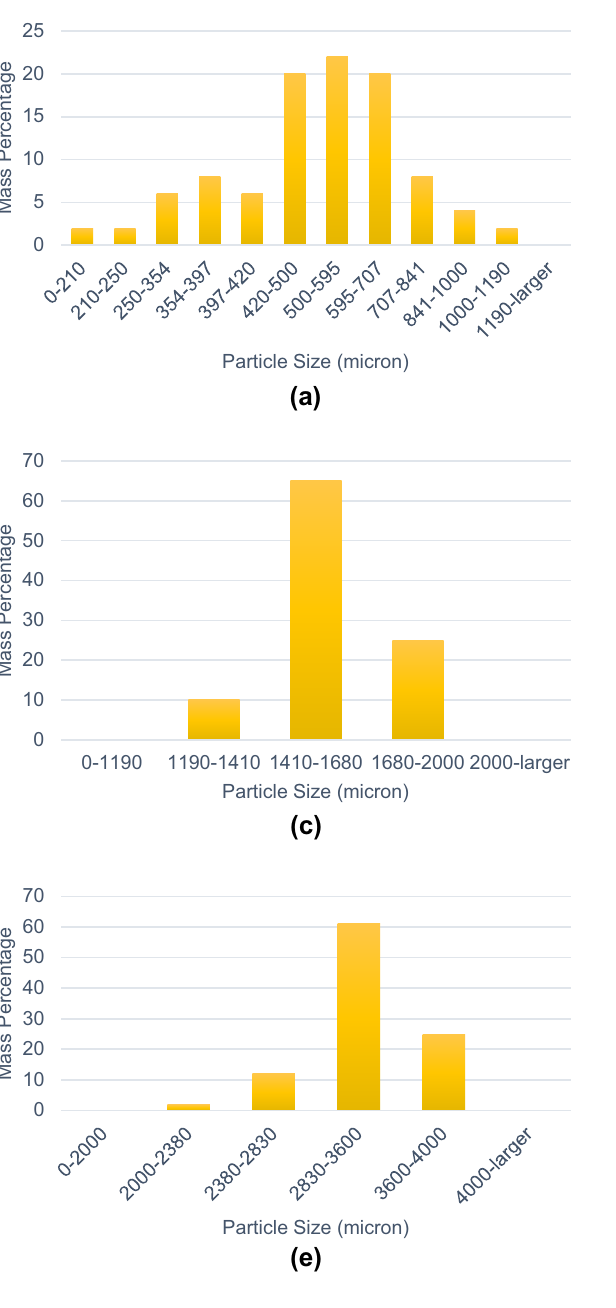
Fig. 9 a Sugarcane Bagasse Fiber particle size distribution